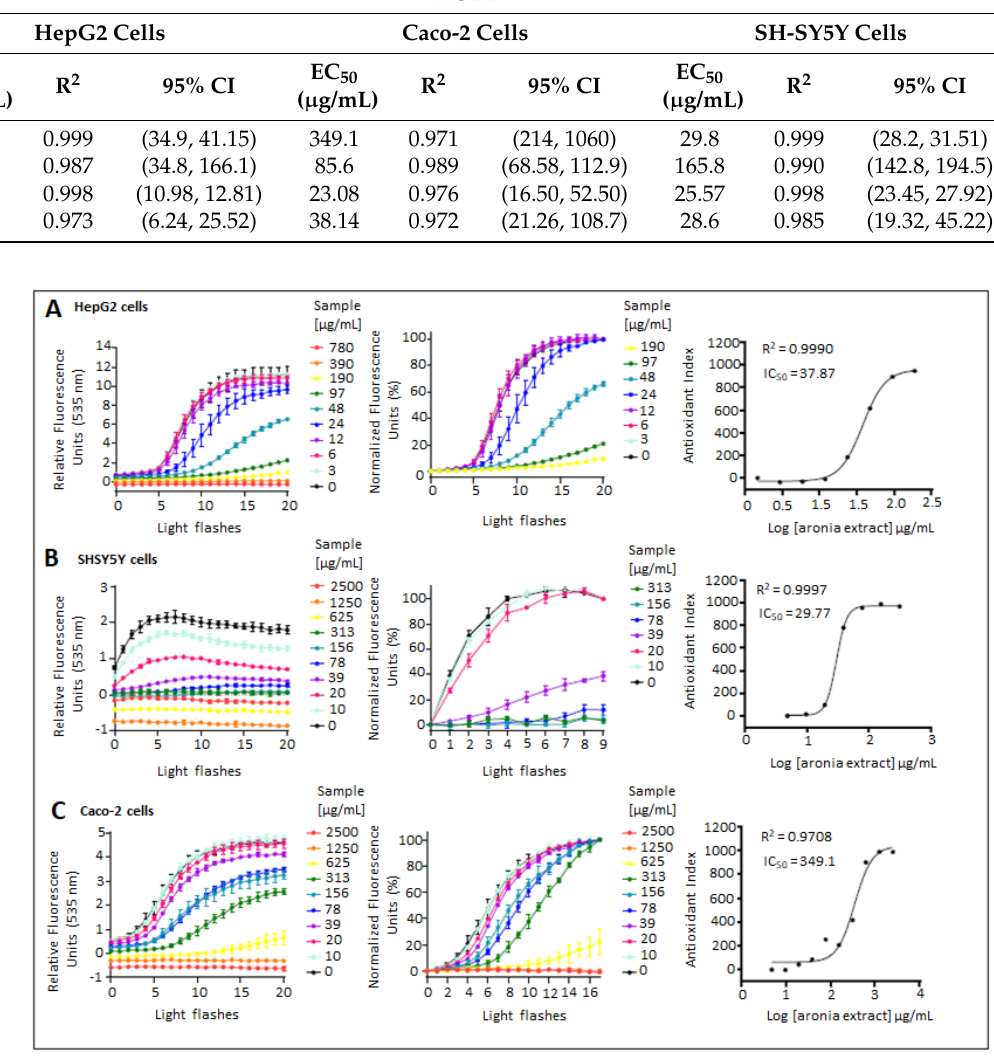
Figure 2. Dose–response curves of AE assessed with the AOP1 assay on different cell lines. HepG2 (panel A ), SH-SY5Y (panel B ) and Caco-2 cells (panel C ) were treated for 4 h with AE in dose–response mode. Left column: kinetic profile of raw data. The raw data (RFUs, relative fluorescence units) were plotted in a kinetics-like mode showing the effect of light flashes on the fluorescence level. Data points, mean RFUs of triplicates; bars, SD. Central column: same data after normalization. Antioxidant indices correspond to control AUC minus data AUCs. Right column: antioxidant-index-based dose– response and sigmoid fit curve used for log EC 50 estimations ( µ g/mL). Data points correspond to measured antioxidant indexes. EC 50 , efficacy concentration which leads to a half-maximal response; R 2 , coefficient of determination obtained by non-linear regression model